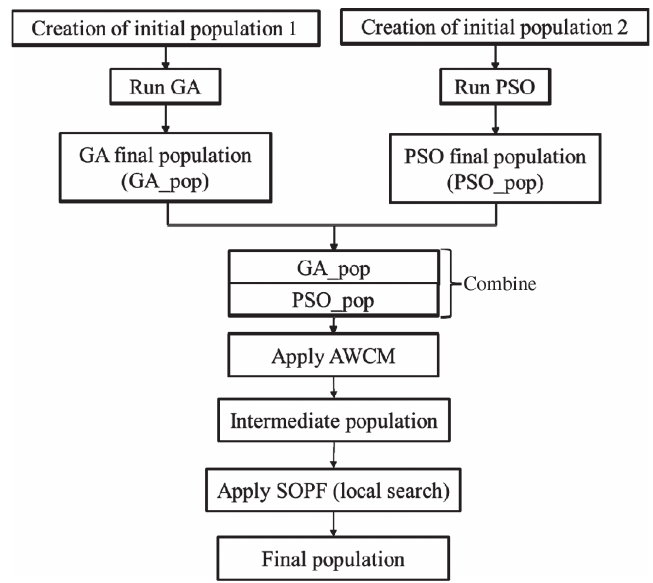
Figure 2: Flowchart of the proposed FS model called